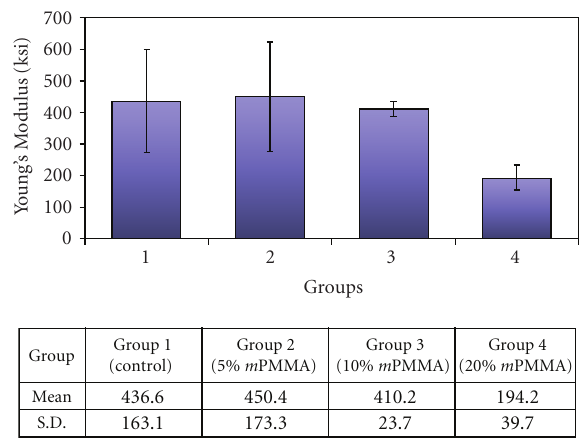
Figure 3: Representation of the mean and standard deviation values for flexural strength for each of the experimental groups.